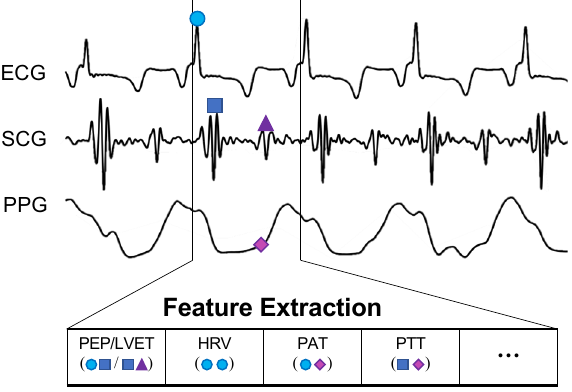
Figure 11. BVDS feature extraction. While the CRM evaluates 30-s segments of the recorded arterial waveform signal, the BVDS metric uses the ECG to segment and analyze all signals on a heartbeat- by-heartbeat level. Fiducial points are detected in each heartbeat and used to calculate cardiac timing intervals and a handful of other clinically relevant features.